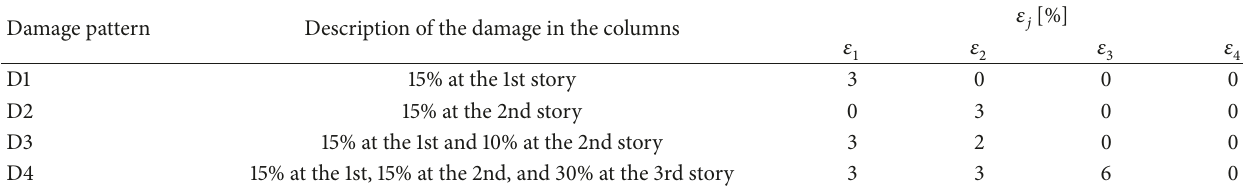
Table 7: Damage patterns. The description is referred to as a single column per story. Damage pattern